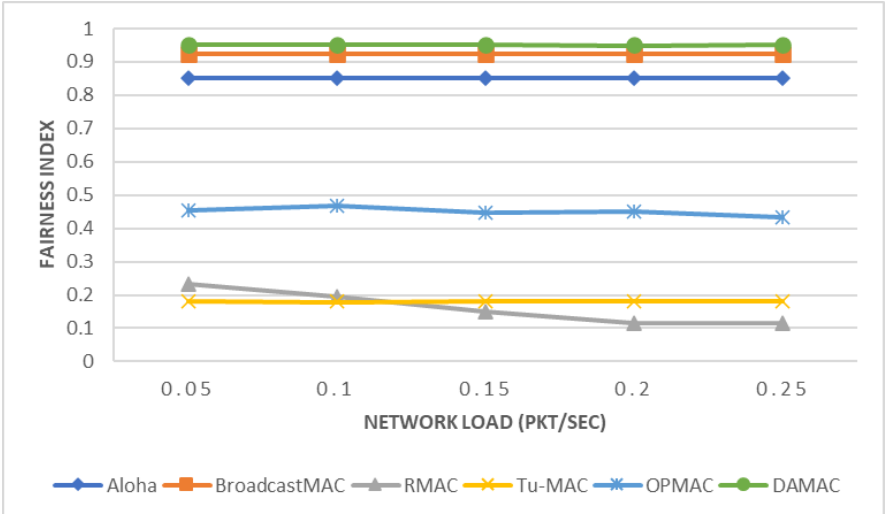
Figure 7. Fairness